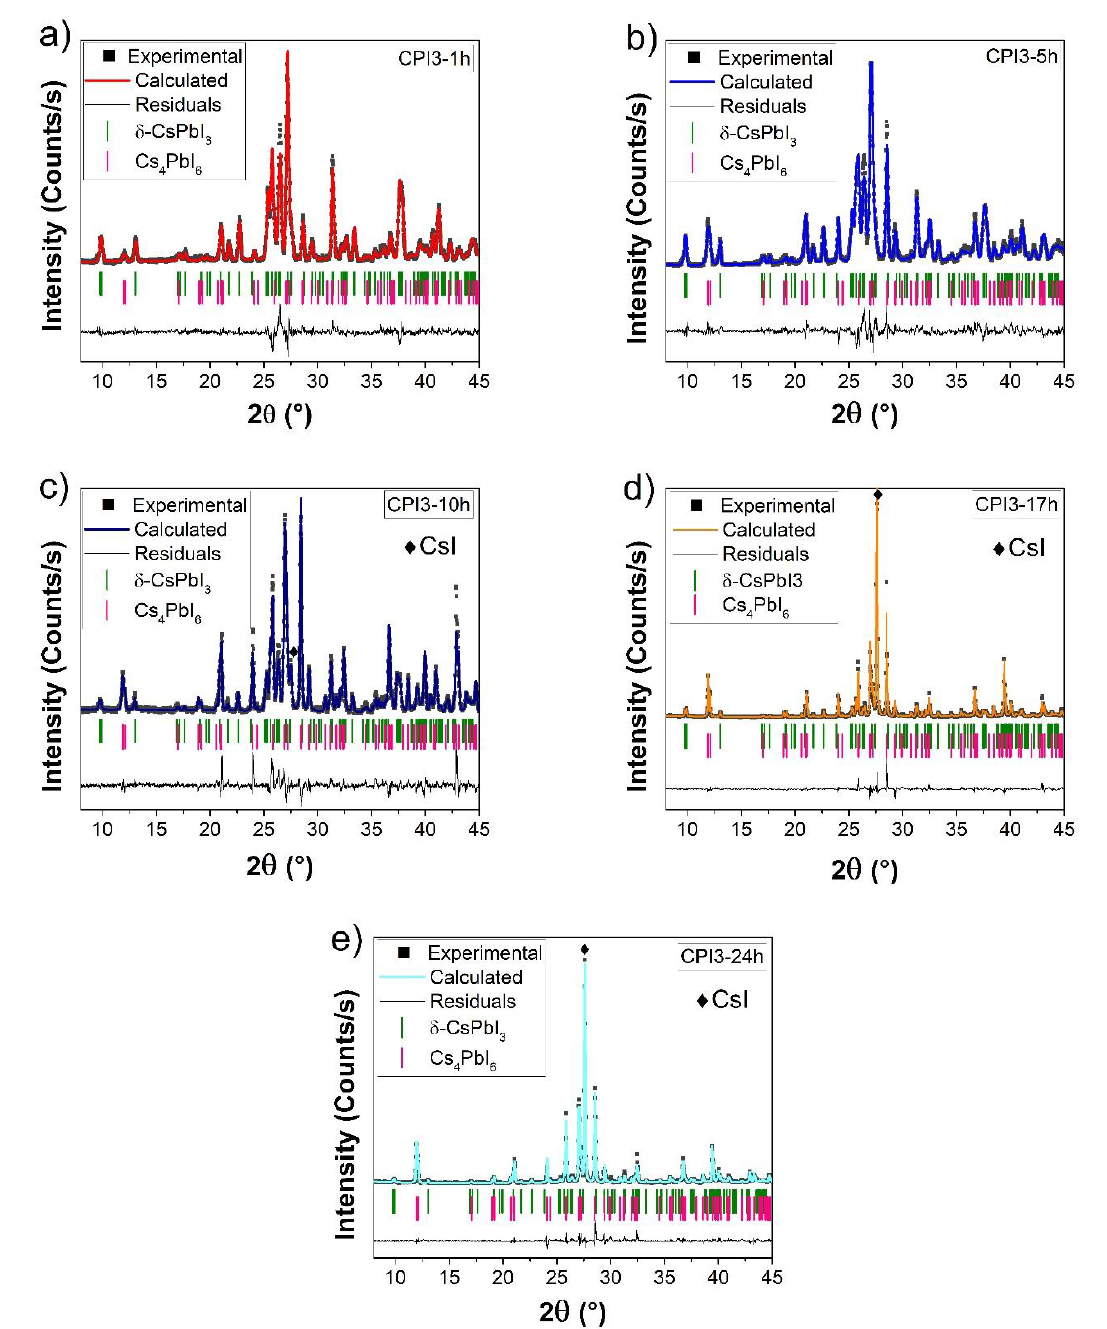
Figure 2. Rietveld refinement of CPI3 samples at different times: ( a ) 1 h, ( b ) 5 h, ( c ) 10 h, ( d ) 17 h, ( e ) 24 h. (cid:4) refers to Experimental pattern, color line is the pattern calculated by Rietveld refinement, in Black line the residuals between experimental and calculated pattern, the vertical bar indicates the theoretical peaks characteristic of δ -CsPbI 3 and Cs 4 PbI 6